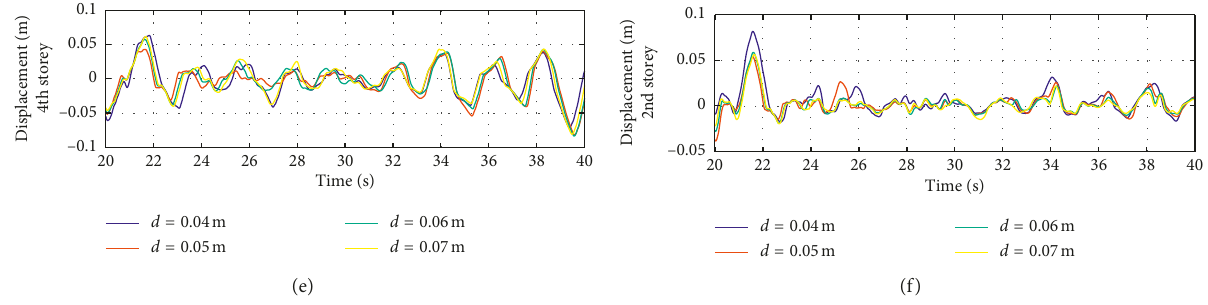
Figure 13: Pounding force with different polymer bumper sizes: (a, e, i) R � 1.0 m; (b, f, j) R � 1.2m; (c, g, k) R � 1.4m; (d, h, l) R �